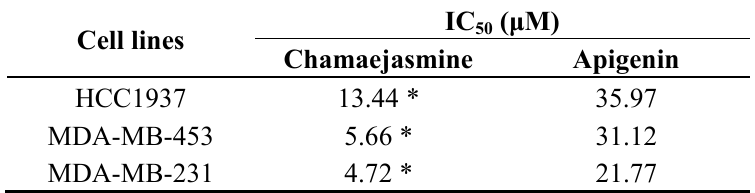
Table 1. Inhibition concentrations 50% (IC HCC1937, MDA-MB-453 and MDA-MB-231 cells determined by MTT assay. * Statistically different from positive control (apigenin, p <